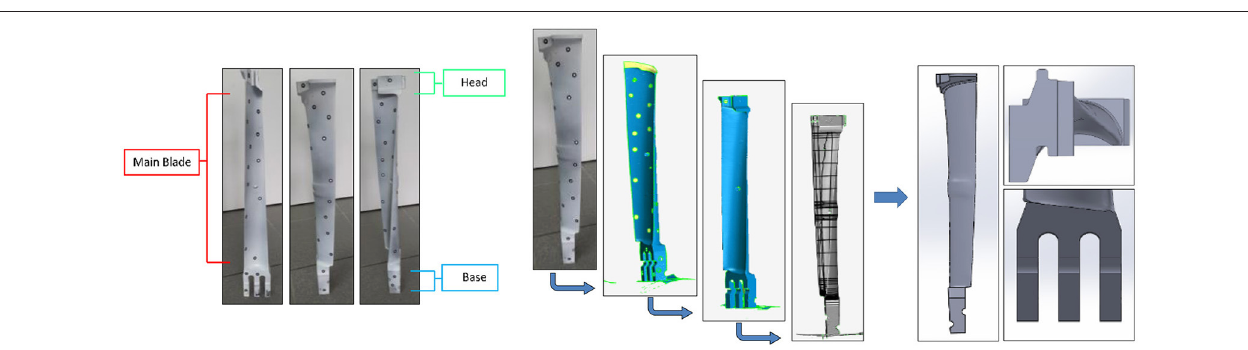
FIGURE 3 | Digitization and final 3D CAD model of a single blade at stage IP 15 of the intermediate pressure turbine.